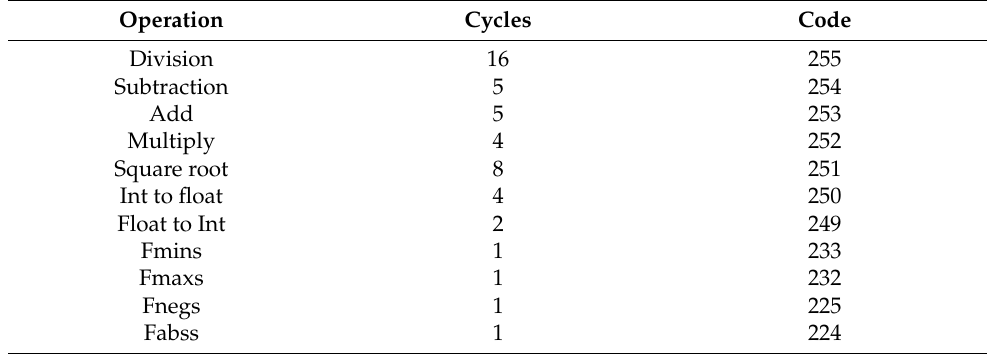
Figure 8. Project Structure in modules. The module architecture must be planned in order to consider the trade-off between time, power and area. Given the physical area constraint of a chip, architecture designers need to determine parameters, such as the size and the amount of the logic and routing resources, so that the designed architectures support high system integration, high per- formance, and high resource utilization [6,20]. In this work, the system described is a real- time simulator, so it is fundamental to have several operations in parallel. Consequently, there will be higher power consumption and a larger area occupied by the projected cir- cuit. This work applied a technique similar to the expression of three solutions to optimize the computation process of Figure 9. As it is a hardware project and the logic used to represent the model describes its physical circuit, it is necessary to use an instance of the Multi-Cycle Custom Instruction DSP block for each arithmetic floating operation. Once